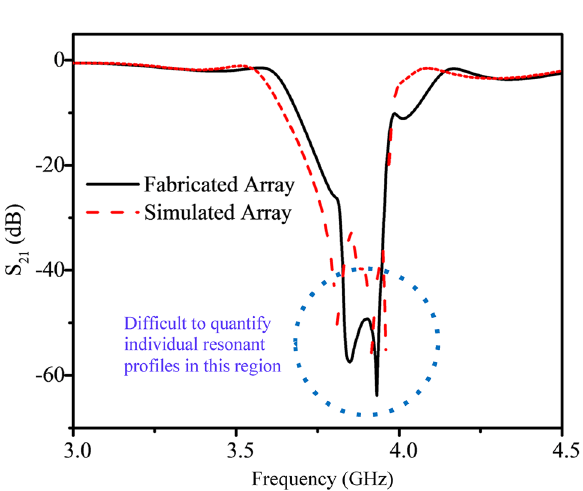
Figure 2. ( a ) The experimental setup with the required equipment labelled, ( b ) the resonator array with each resonator distinctly labelled for analysis (A through F), and ( c ) the resonator array with the integrated microfluidic channel and Galinstan aligned over resonator A .